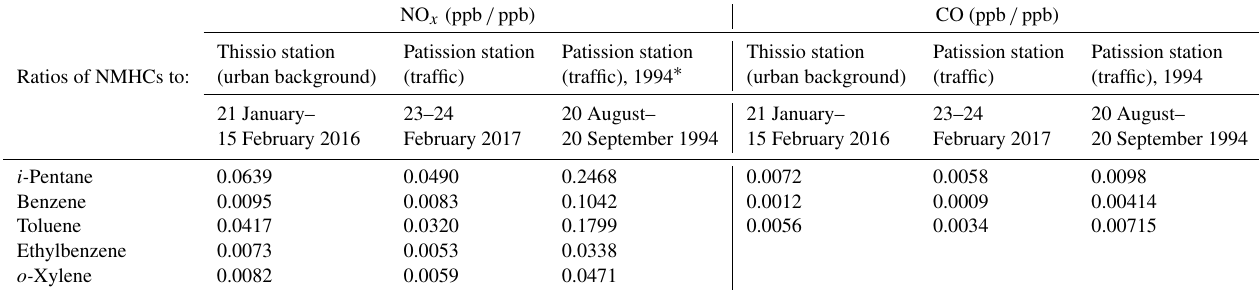
Table 2. Enhancement ratios of NMHC to NO x (ppb / ppb) and to CO (ppb / ppb), calculated from the present dataset for Thissio station and the street canyon measurements (Patission station) for the traffic rush hour periods. The enhancement ratios presented in the third and sixth column are reported in Kourtidis et al. (1999) and were calculated for the same station in the street canyon.